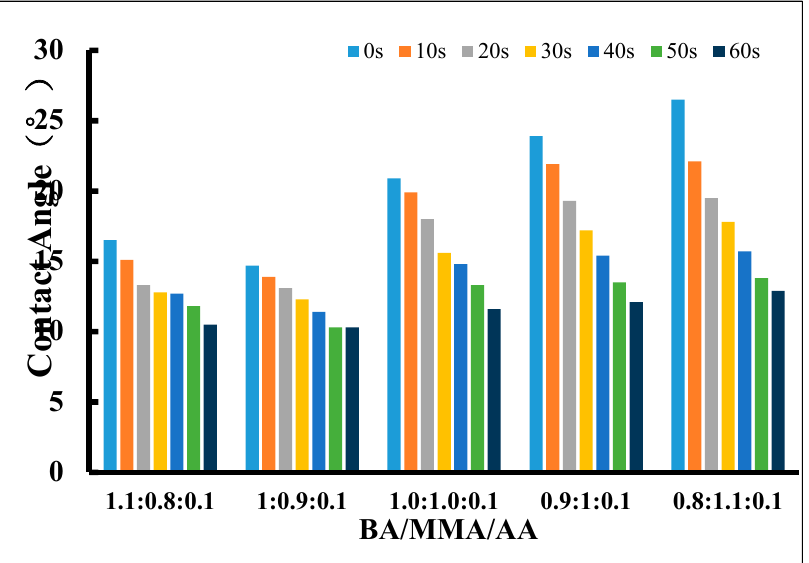
Figure 3. Dynamic contact angle of different monomers’ ratio butyl acrylate (BA)/methyl acrylate (MMA)/acrylic acid (AA).